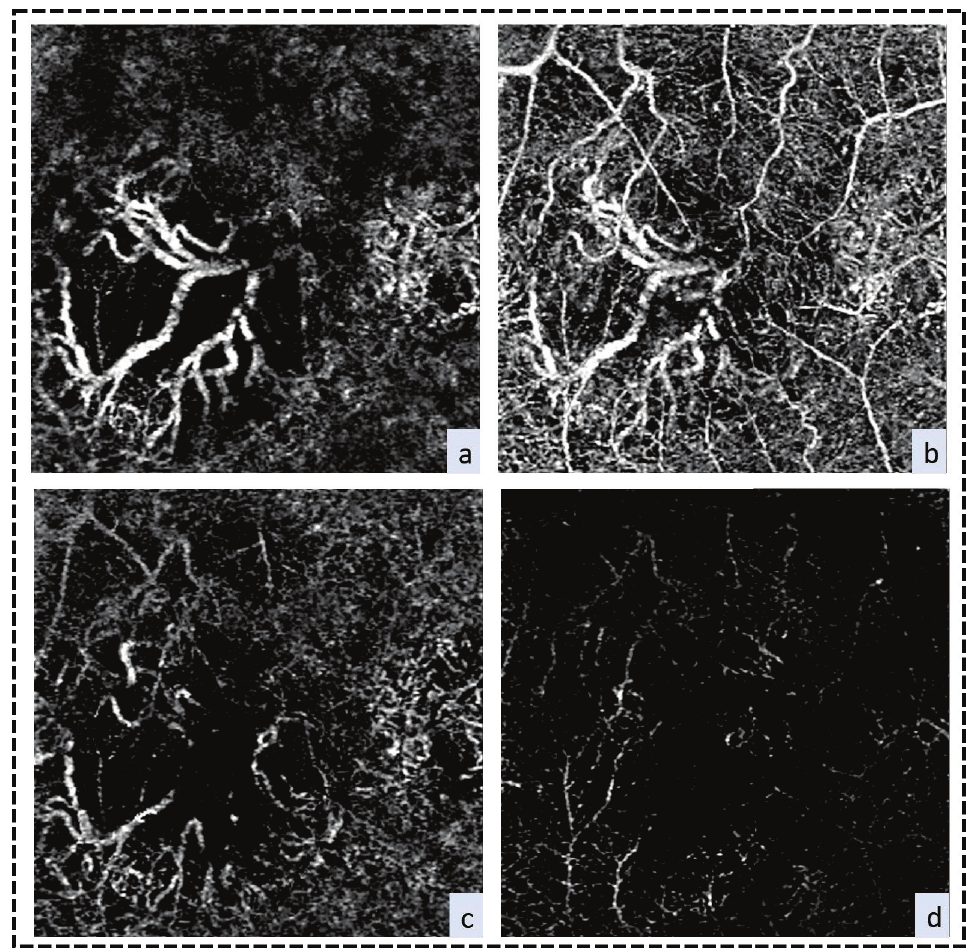
Figure 4. AMD. OCTA scan showing different plexuses for an AMD subject: ( a ) choroid layer, ( b ) whole retina, ( c) Choriocapillaris layer, and ( d ) avascular